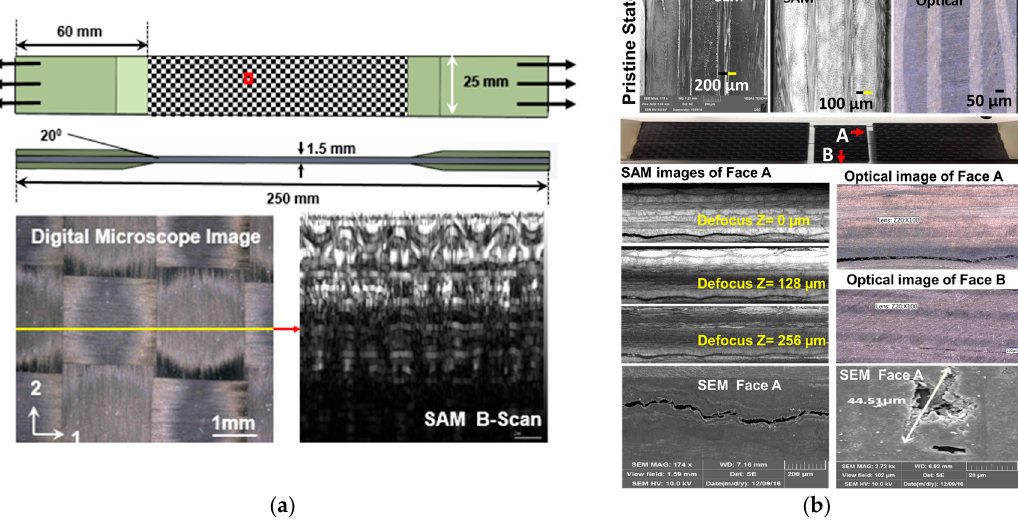
Figure 1. ( a ) Schematic of specimen geometry: Pristine internal structures are shown by digital microscope and scanning acoustic microscope; ( b ) Damages in woven composite specimen observed after ~2 million cycles, delamination started after ~1 million cycles.